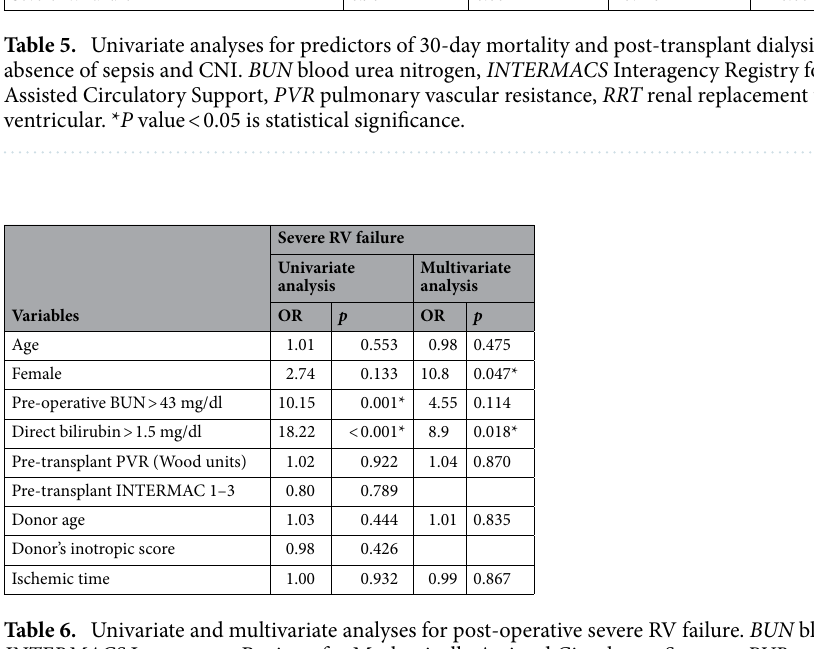
Table 6. Univariate and multivariate analyses for post-operative severe RV failure. BUN blood urea nitrogen, INTERMACS Interagency Registry for Mechanically Assisted Circulatory Support, PVR pulmonary vascular resistance, RRT renal replacement therapy, RV right ventricular. * P value < 0.05 is statistical significance.